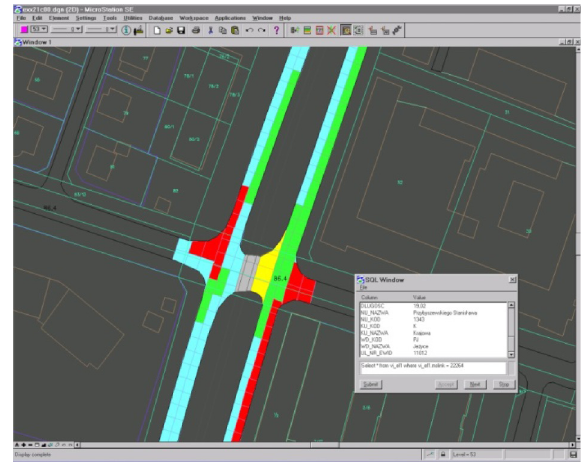
Fig. 13. Pavement condition analysis (Rydzewski, Sztukiewicz 2005) – e.g. the green colour may well indicate the road sections with reduced bearing capacity of subgrade